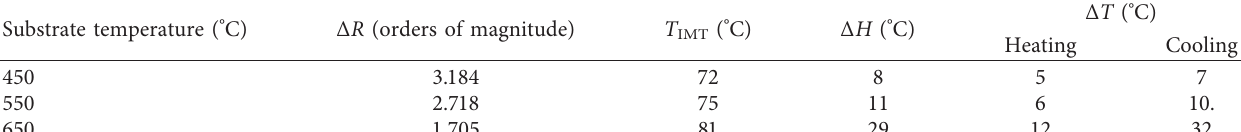
2 (M) films grown at different temperatures.